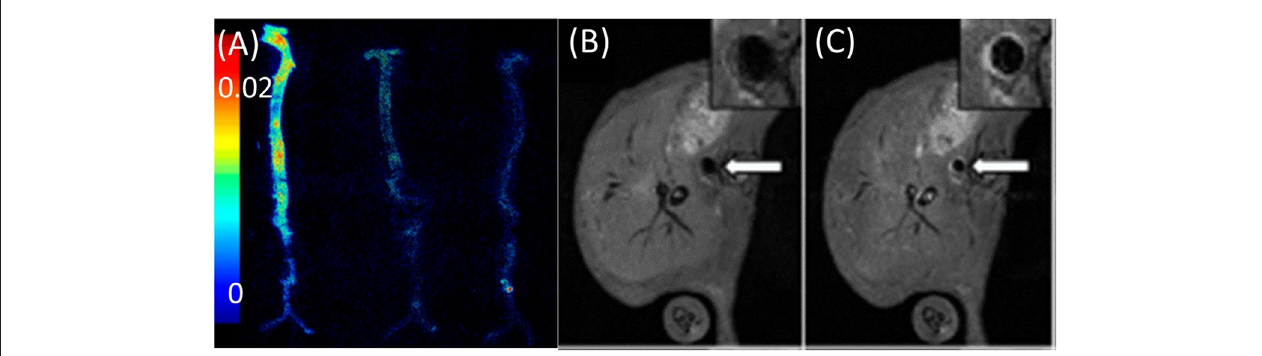
FIGURE 4 | Imaging of adhesion molecules. (A) Ex vivo fluorescence image of aortas obtained by VCAM imaging of apoE − / − mice injected with (from left to right) VCAM-TMV, PEG-TMV, and PBS, respectively. (B) Pre-injection and (C) post-injection MRI scans of VCAM-TMV in apoE − / − mice. Insets show magnified images of abdominal aorta with regions of interest [adopted from (12)]. VCAM, vascular cell adhesion molecule; PEG, Polyethylene glycol; TMV, Tobacco mosaic